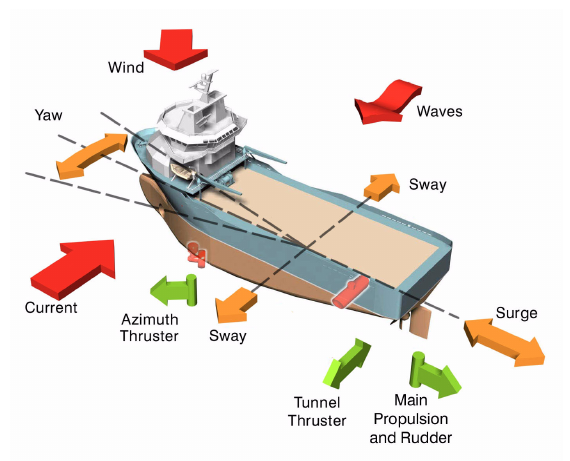
Figure 9: A DP vessel positions itself in the desired de- grees of freedom (orange arrows) by counter- acting the environmental forces (red arrows) through its propulsors (green arrows). Cour- tesy of Kongsberg